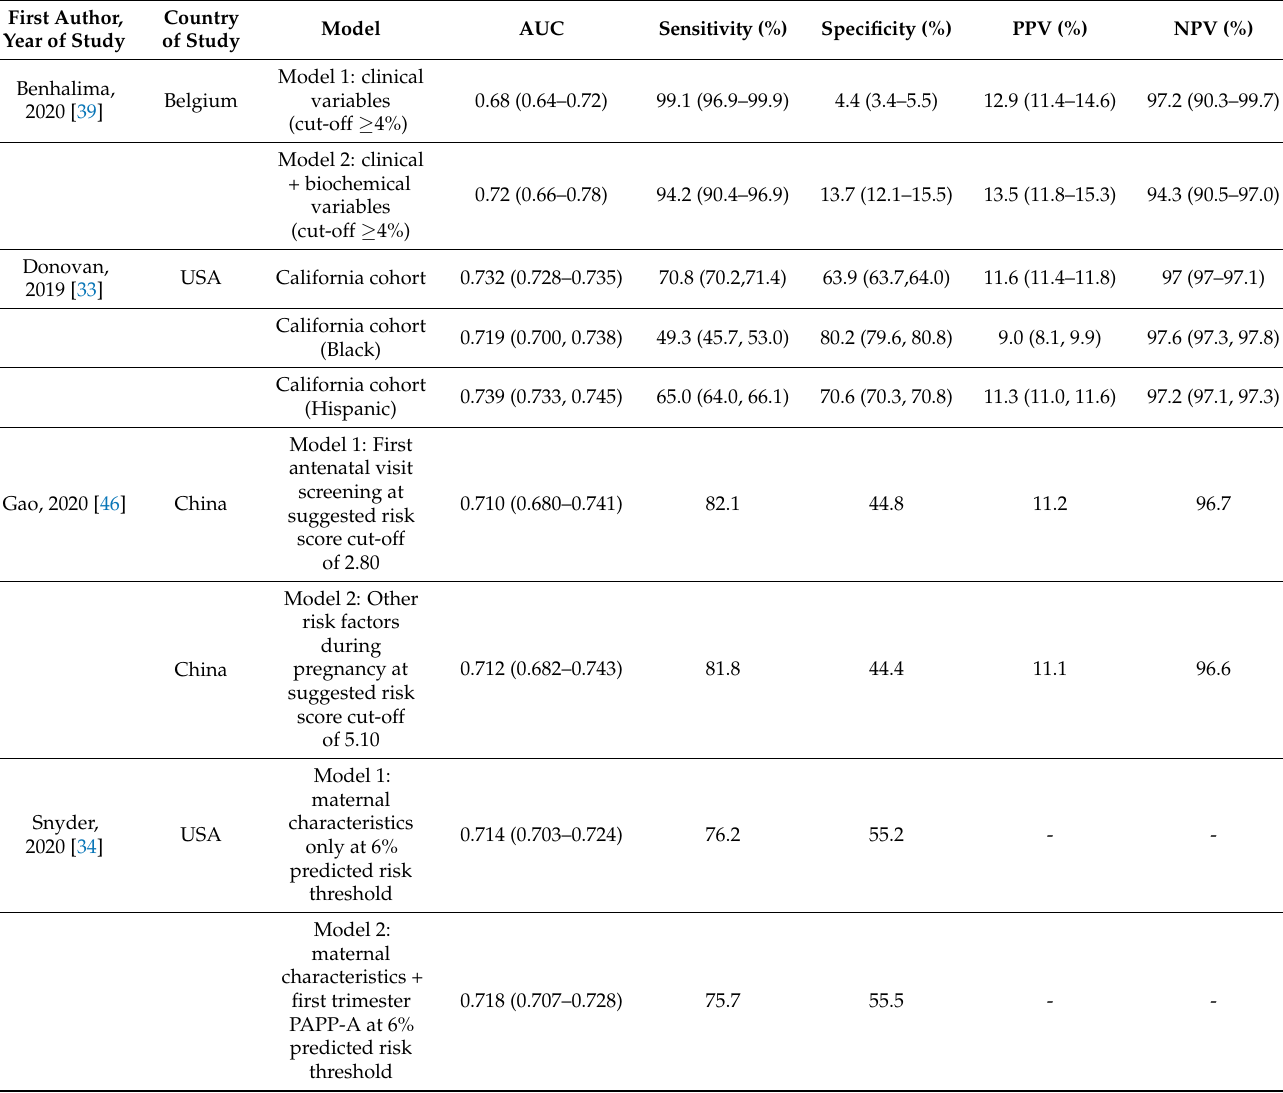
Table 2. Model performance metrics for GDM